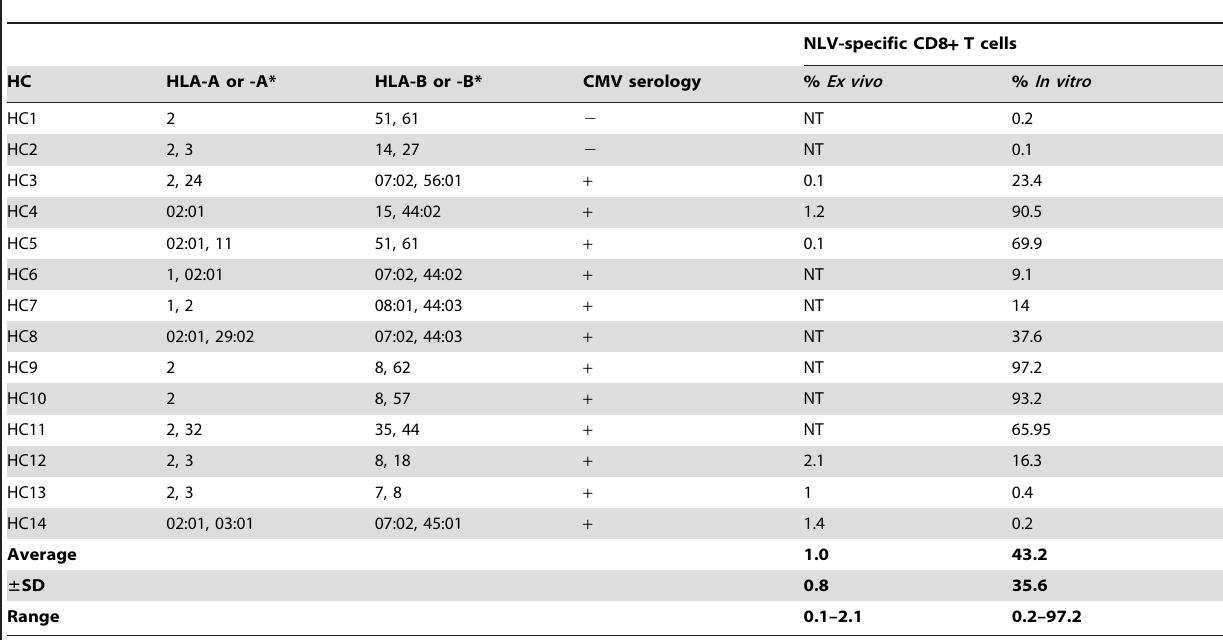
Table 2. Healthy controls (HC) demographics and NLV expansion